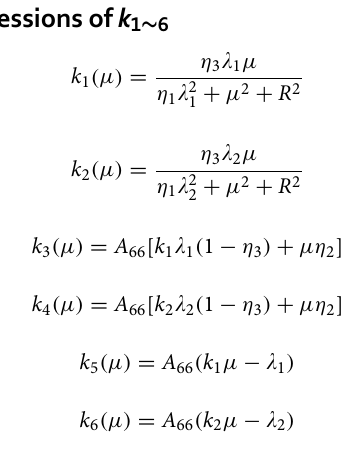
E for ( a ) orthotropic C–C–C–C square plates x 2 (cid:31)